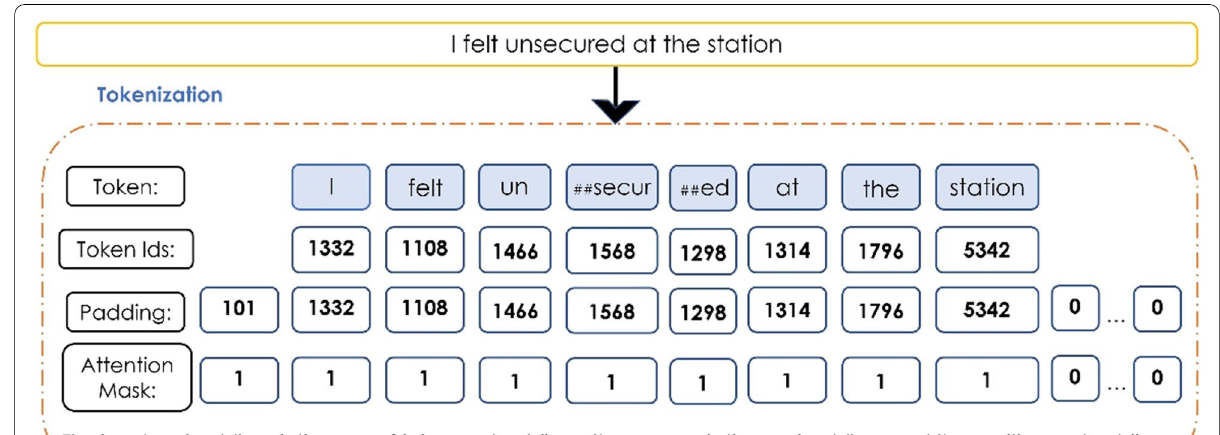
Fig. 1 Input sequence diagram. Source: